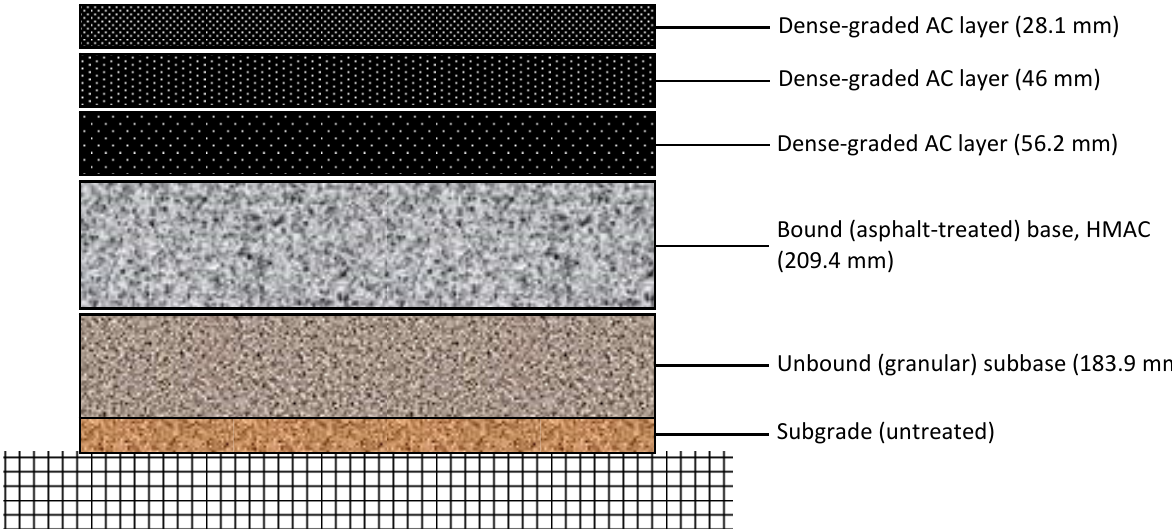
Figure 1. Pavement cross-section of LTPP test section 36-1643 (not in scale; data source: [33]).